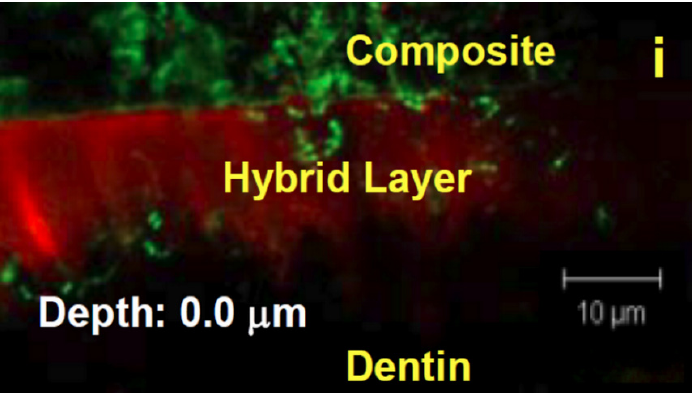
Figure 3. An image of the hybrid layer taken using confocal laser scanning microscopy (CLSM).